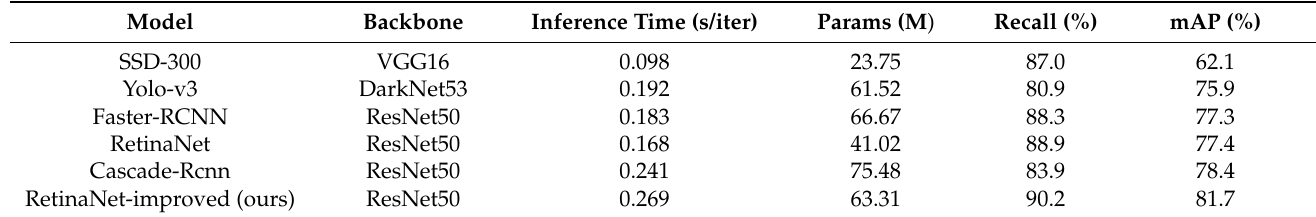
Table 2. The results of different models on our